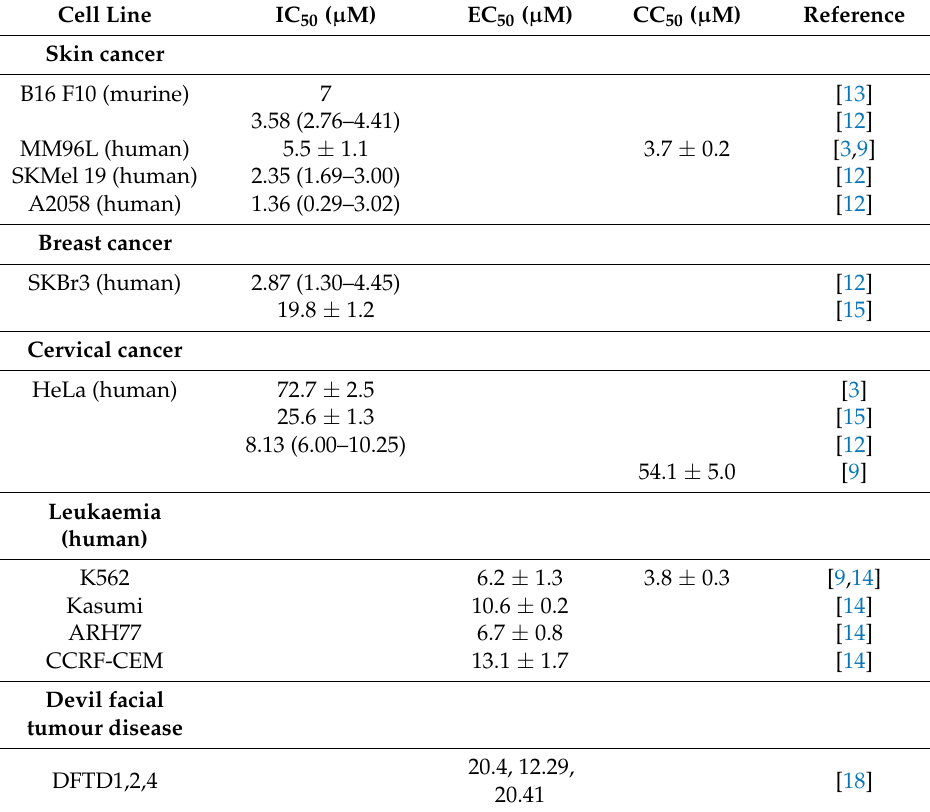
Table 2. Anti-cancer activity of Gm against the most commonly tested cell lines, reported as IC 50 , EC 50 and/or CC 50 ± standard deviations. Numbers is brackets indicate a 95% confidence